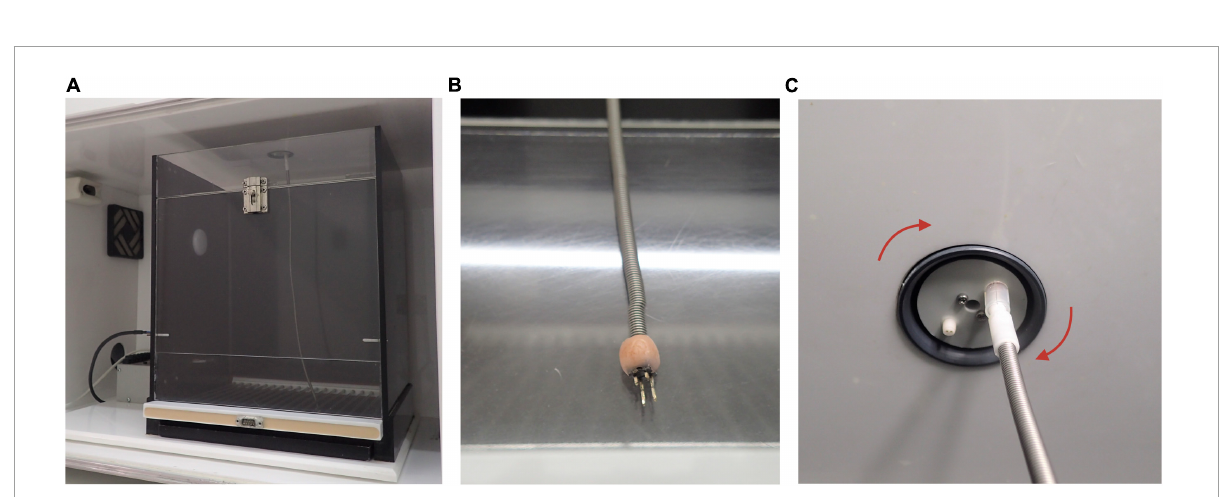
FIGURE3 Picture of Skinner box used and details. (A) Clear door Skinner box used for intracranial electrical self-stimulation (ICSS)/experimenter-administered stimulation (EAS) administration. Note that there is not a high level of lighting. This is due to standardized behavioral testing conditions from our lab. (B) Male pin is used to connect the stimulator to the female entrance of the stimulation electrode. Note that acrylic cement is used to fix the male pin to the cable connected to the stimulator. (C) The wire connected to animals’ female pin is attached to the electrode swivel located in the Skinner box ceiling order to provide rotational movement to animals.